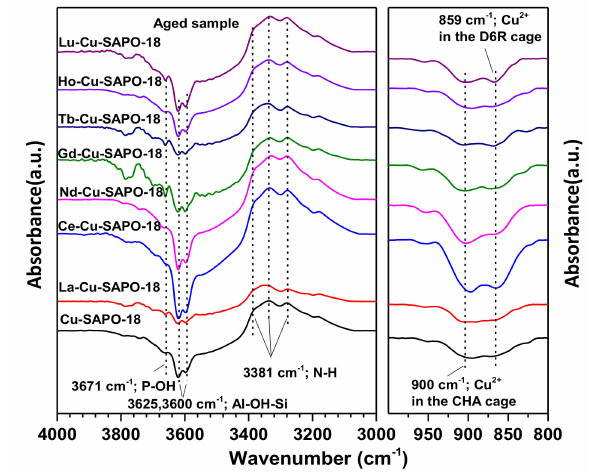
Figure 13. DRIFT spectra of NH 3 adsorbed on the hydrothermally aged Cu-SAPO-18 and M-Cu-SAPO-18 samples. Experimental conditions: the sample was exposed to 500 ppm NH 3 (N 2 as the balance gas) at 30 o C for 1 h, and the total flow was 100 mL /